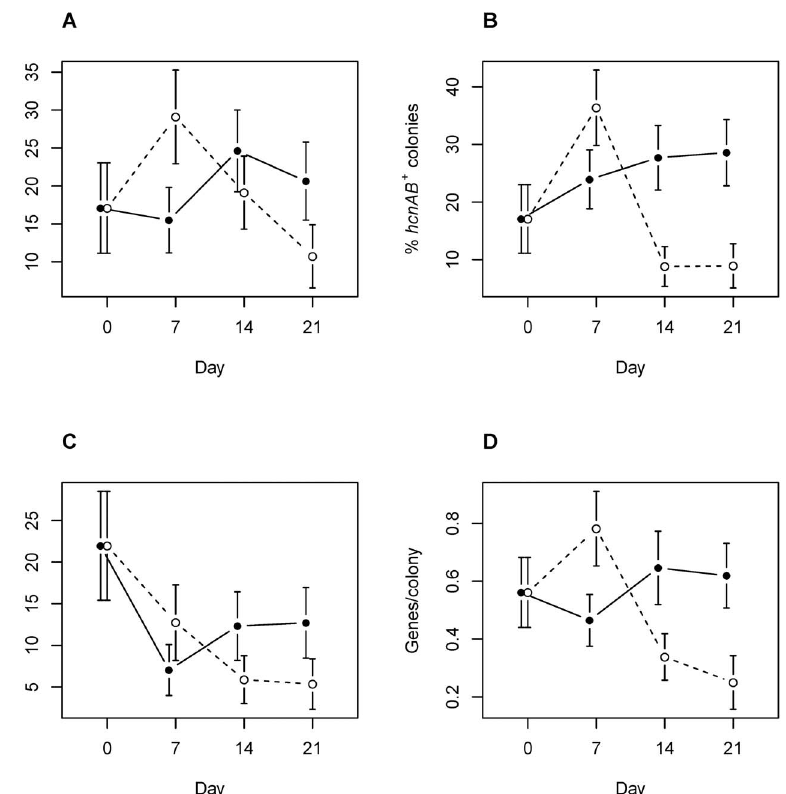
Figure 1. Effect of Acanthoebacastellanii on the frequency of phlD , hcnAB and prnD positive Pseudomonas (A–C) and on the average number of genes per bacterium (D) during the microcosm experiment with barley (means ± SE). Presence of each gene was tested by colony–PCR on isolates growing on the Pseudomonas specific Gould’s S1 medium. closed symbols: bacterial communities co-cultivated with Acanthamoeba castellanii , open symbols: control treatment without protozoa.